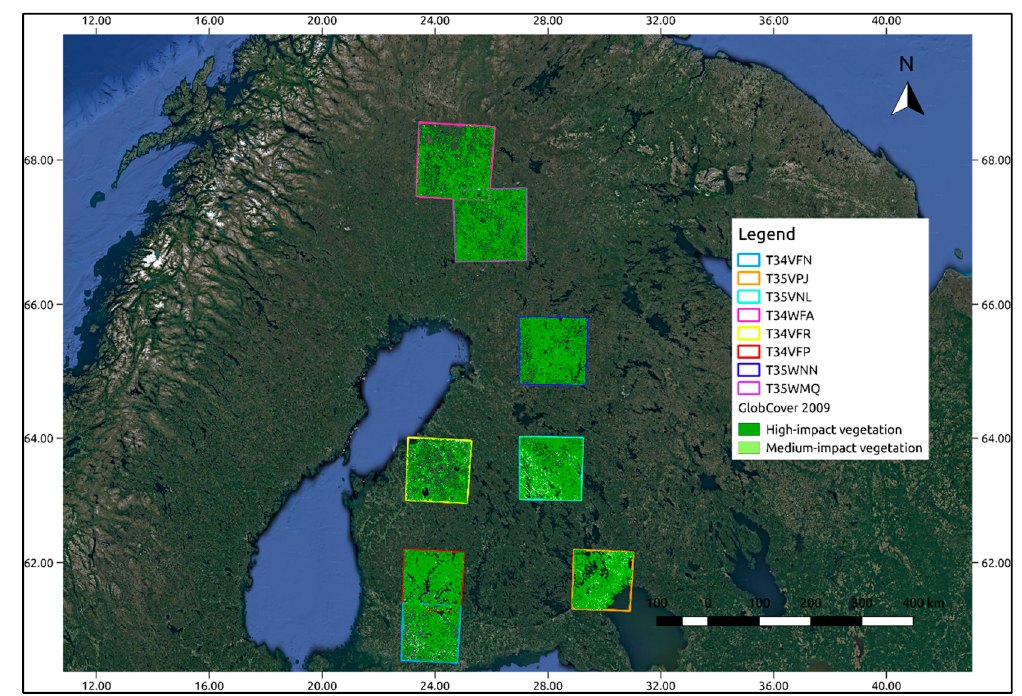
Figure 5. Selection of S-2 tiles in Finland. Geosciences 2018 , 8 , x FOR PEER REVIEW